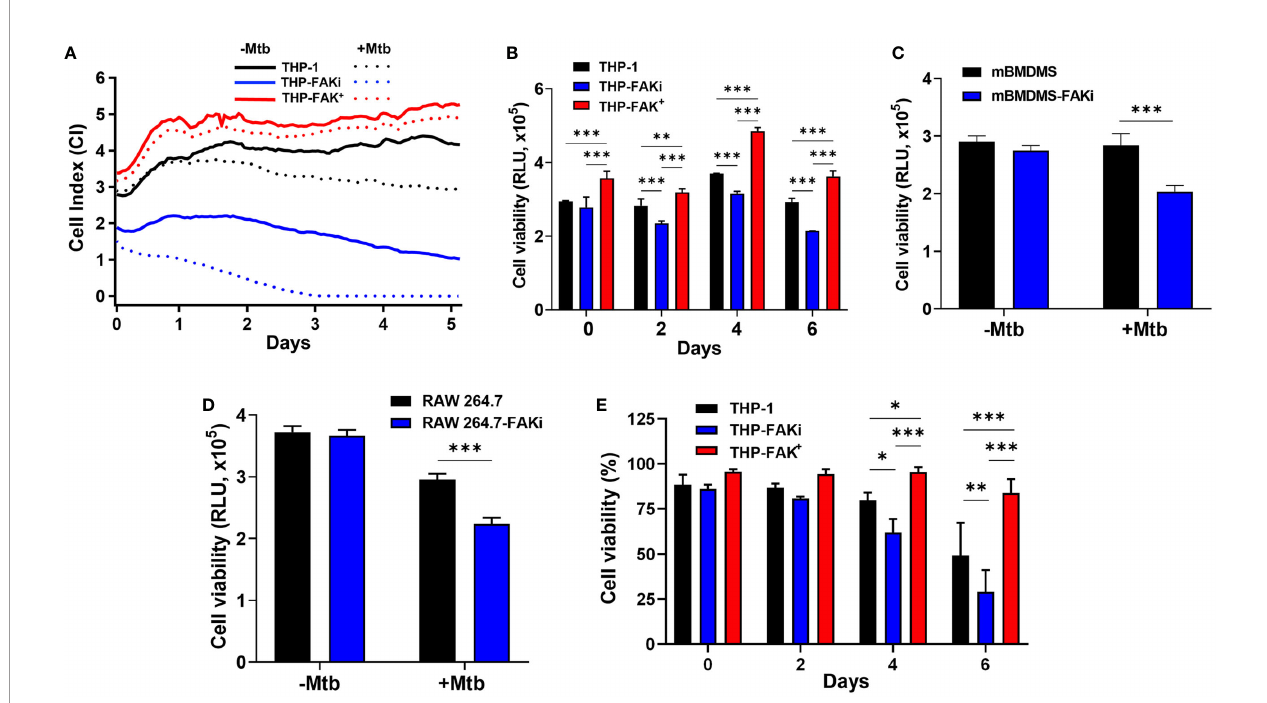
FIGURE 4 | FAK is required to block cell death of Mtb-infected macrophages. (A) THP-1, THP-FAKi and THP-FAK + macrophages were infected with Mtb at an MOI of 10, after which changes in adherence (viability) were monitored by RTCA as indicated by the Cell Index (CI). CI was measured continuously every hour for 120 hours post-infection. The data represent the mean of three independent biological replicates. (B) THP-1, THP-FAKi, THP-FAK + macrophages, (C) mBMDMs, and (D) RAW 264.7 cells were infected with Mtb at an MOI of 10 and cell viability was quanti fi ed using Cell Titer-Glo (measured as Relative Luminescence Units, RLU). Data in (C, D) represent 4 days post-infection. (E) THP-1, THP-FAKi, and THP-FAK + macrophages were infected with Mtb at an MOI of 10, and at the indicated time points post-infection, cells were stained with Fixable Viability Stain (FVS780) dye and analyzed using fl ow cytometry to measure the percentage of viable cells. Error bars represent the mean ± SD of three independent biological replicates. * p < 0.05, ** p < 0.01, *** p <